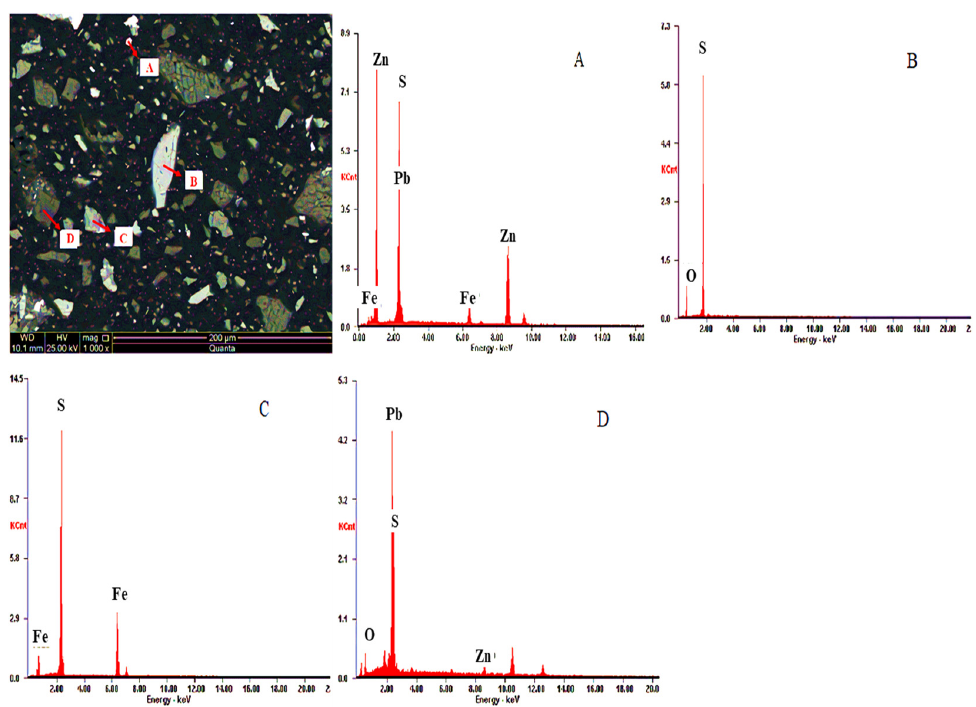
Figure 4. The EDAX spectra of the complex zinc ore. Table 3. The distribution of the zinc phases in the complex zinc